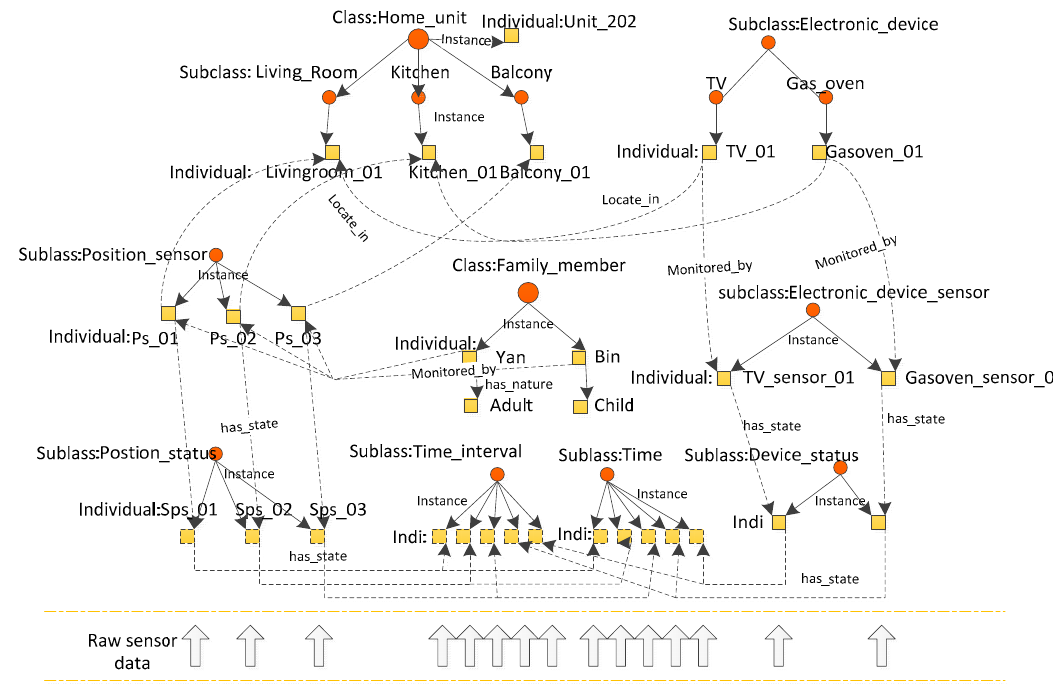
Figure 17. The updated knowledge base in the example.